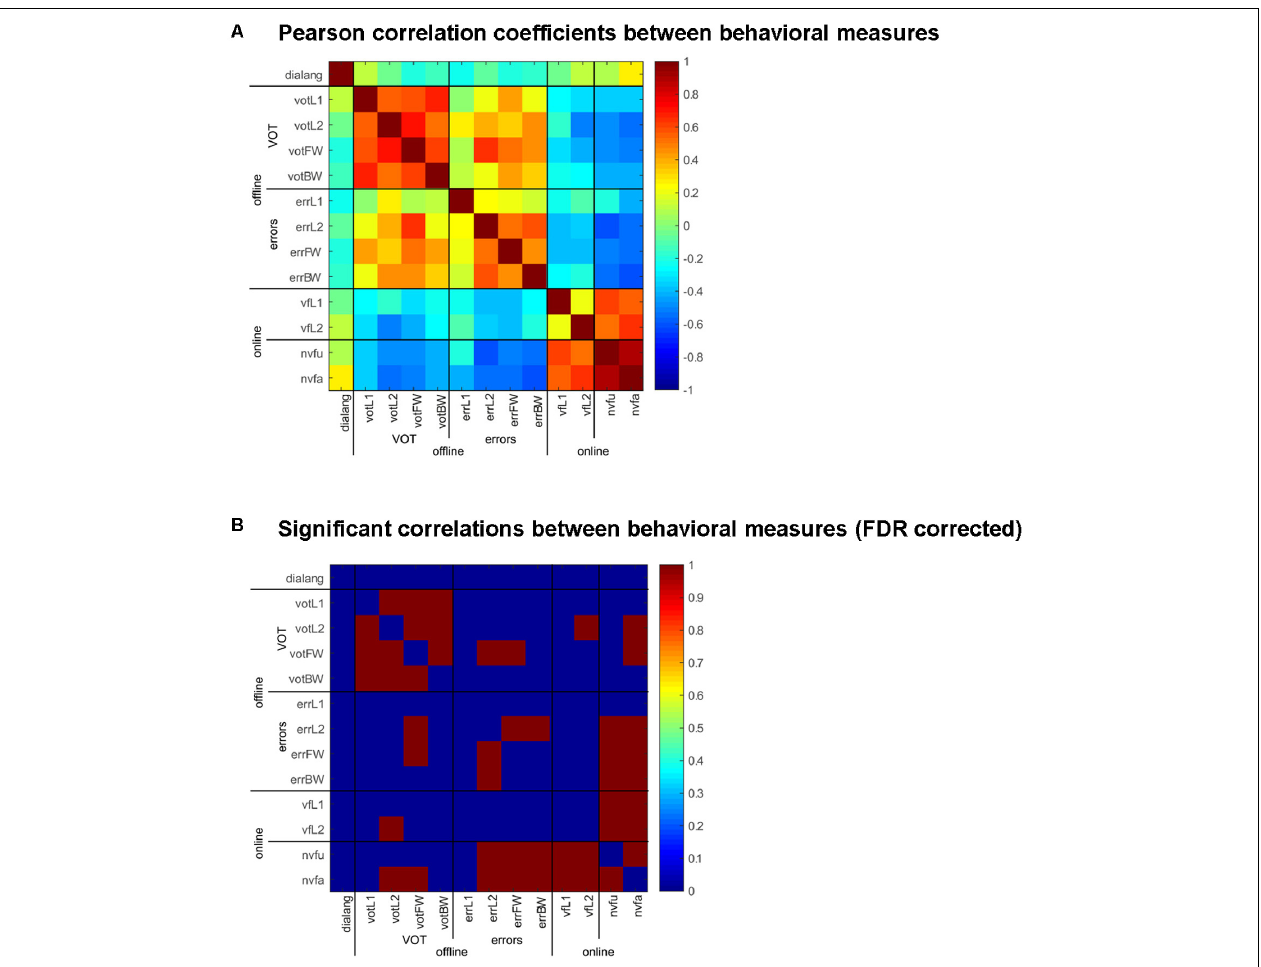
FIGURE 3 | Correlation of behavioral measures in the online and offline tasks and the DIALANG measures. (A) Pearson correlation coefficients between the behavioral measures (VOT and errors) in the offline tasks (naming in L1 and L2 and forward and backward translation) and the online tasks [verbal fluency in L1 and L2 and non-verbal fluency (unique and all designs)] comparing sham vs. anodal-tDCS stimulation. Warm colors indicate positive correlations, cold colors indicate negative correlations. (B) Significant [FDR-corrected (adjusted p -value: p = 0.011)] correlations between the behavioral measures are indicated in red, and non-significant values in